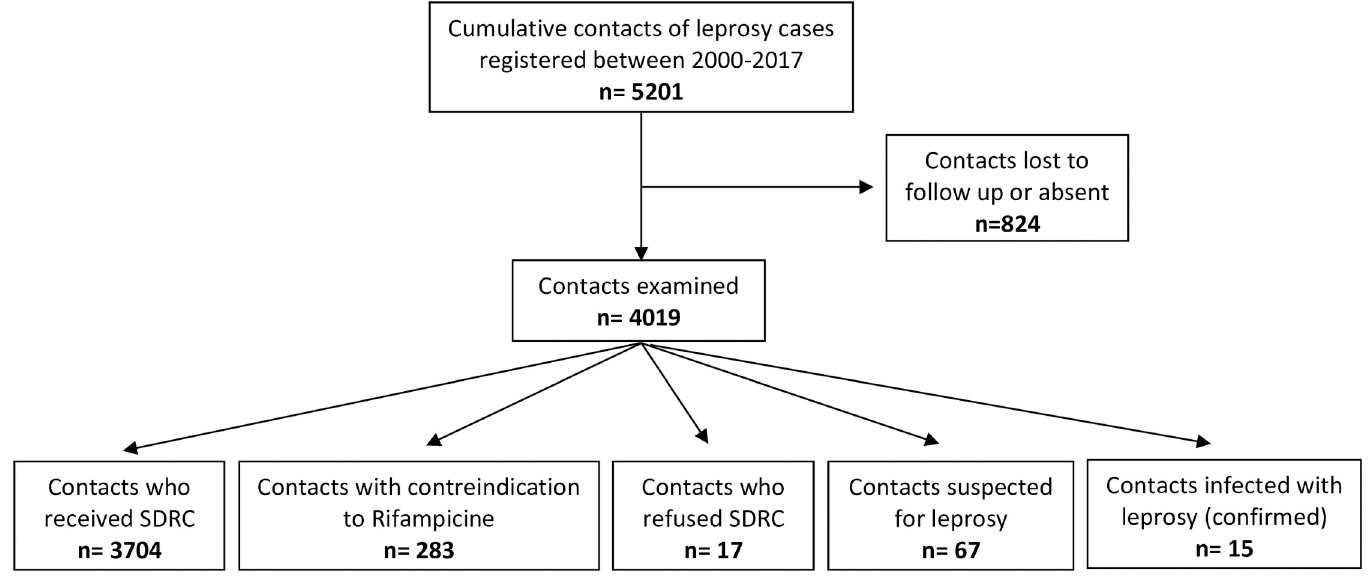
Fig 1. Flow chart of contact investigations and implementation of single dose rifampicin chemoprophylaxis.